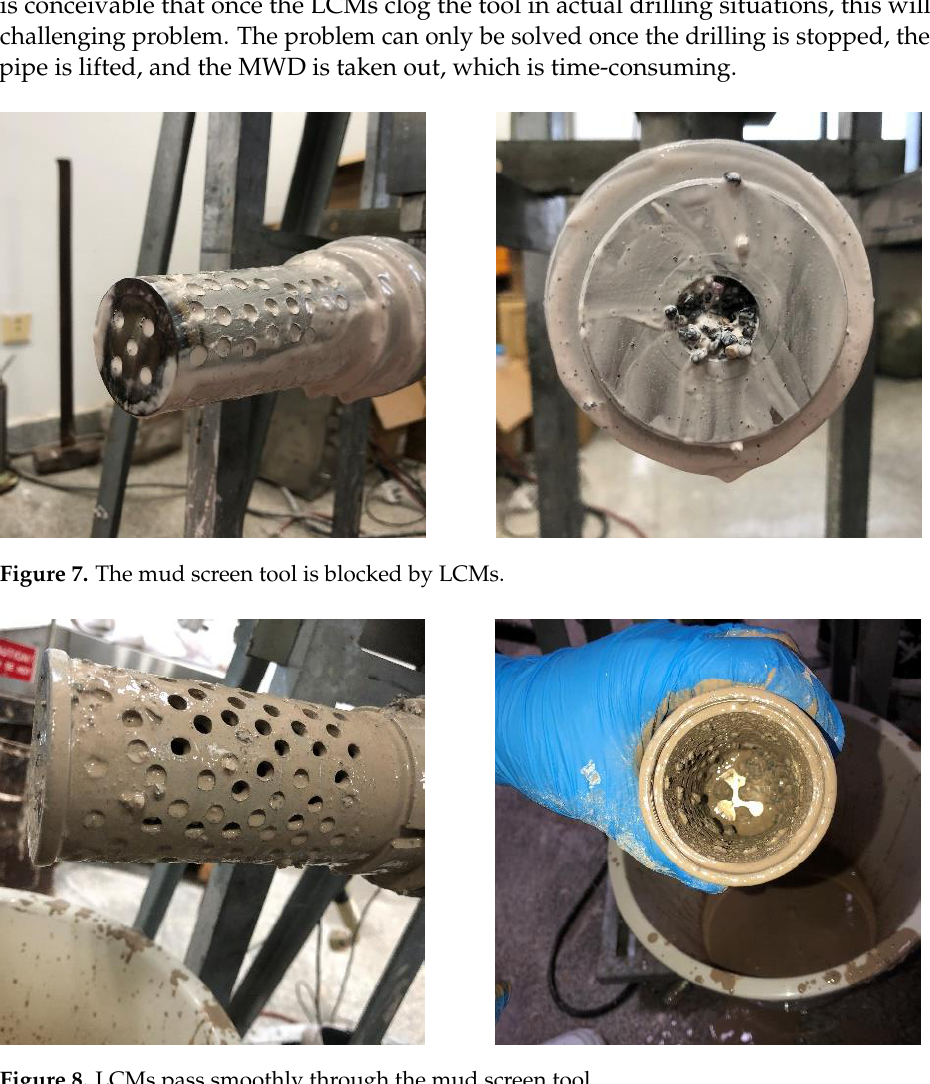
Figure 6. Flow properties of materials for plugging while drilling with different particle size in mud screen.